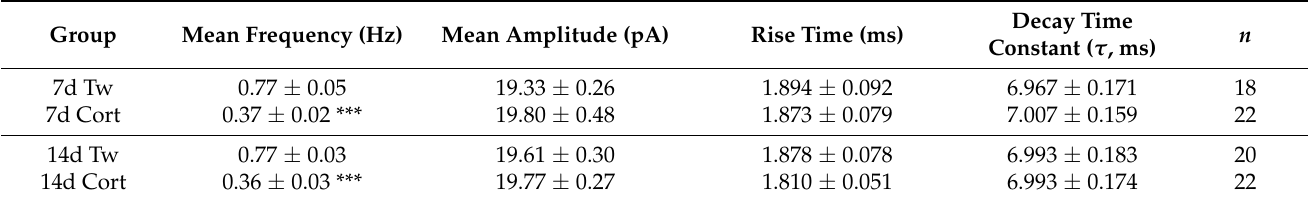
Table 3. Effects of corticosterone and restraint stress on parameters characterizing sIPSCs (mean ±